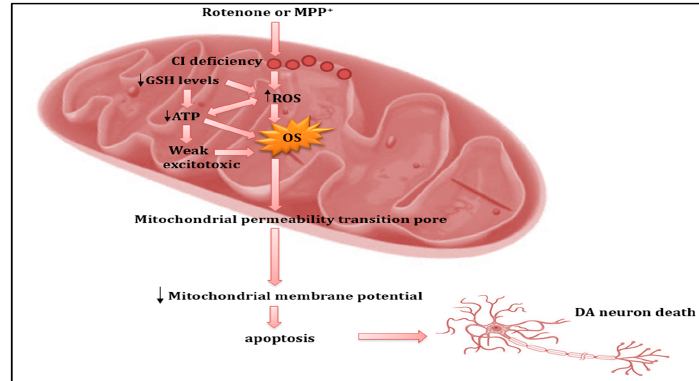
Figure 3. A schematic showing the role of mitochondrial dysfunction in the pathogenesis of Parkinson’s disease (PD). Neurotoxins, such as rotenone or 1-methyl-4-phenylpyridinium (MPP + ) elicit MRC complex I deficiency, and subsequently generate reactive oxygen species (ROS), reducing levels of the antioxidant glutathione (GSH), with resulting oxidative stress. Oxidative stress induces mitochondrial permeability by transiently opening a pore, which subsequently causes depolarization of the mitochondrial membrane potential. These events ultimately lead to neural cell death via the release of pro-apoptotic mitochondrial proteins, including cytochrome c and apoptosis-initiating factor. DA: